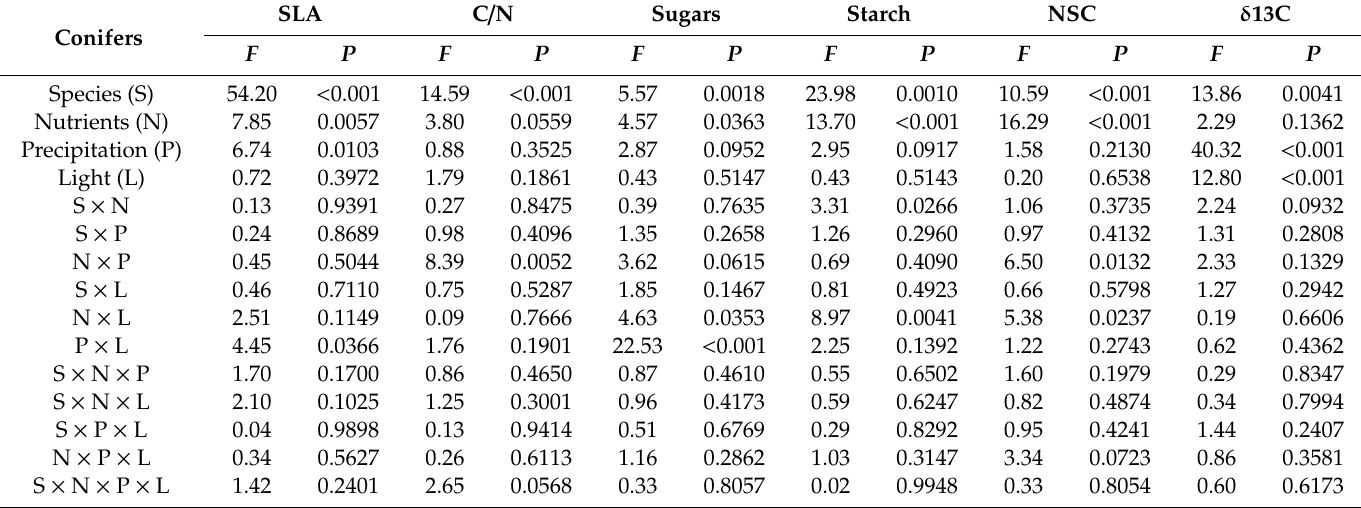
Table 1. Linear mixed model results of the e ff ects of species (S), precipitation (P), shading (L), and nutrients (N) on the specific leaf area (SLA), foliar C / N ratio, foliar soluble sugars concentration, foliar starch concentration, foliar total non-structural carbohydrate concentration (NSC), and foliar carbon isotope fractionation ( δ 13C) of evergreen